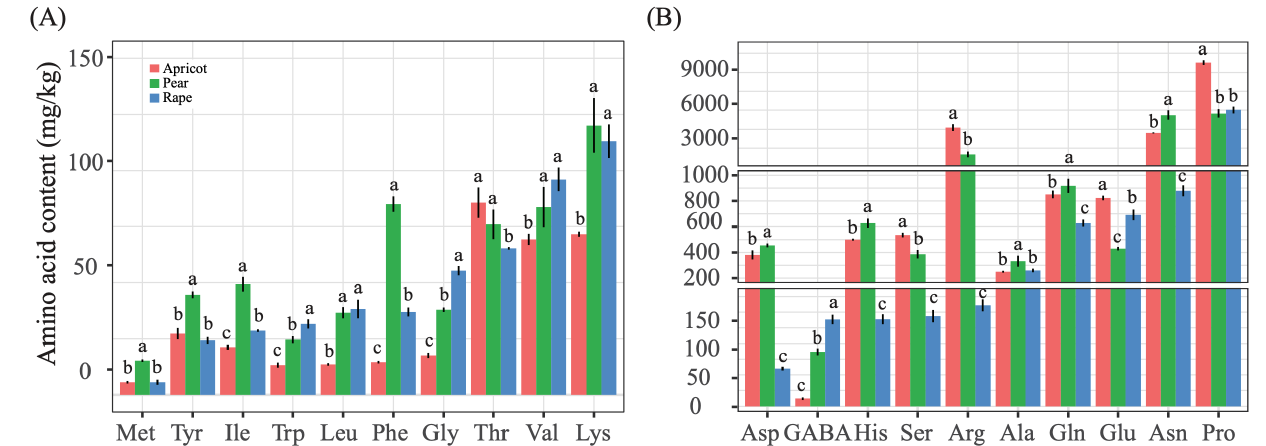
Figure 1. Levels of different amino acids in pear ( Pyrus bretschneideri ), rape ( Brassica napus ) and apricot ( Armeniaca sibirica ) pollen. ( A ) Met = methionine, Tyr = tyrosine, Ile = isoleucine, Trp = tryptophan, Leu = leucine, Phe = phenylalanine, Gly = glycine, Thr = threonine, Val = valine, and Lys = lysine. ( B ) Asp = aspartic acid, GABA = γ -aminobutyric acid, His = histidine, Ser = serine, Arg = arginine, Ala = alanine, Gln = glutamine, Glu = glutamic acid, Asn = asparagine, and Pro = proline. Different letters indicate a significant difference ( p < 0.05).